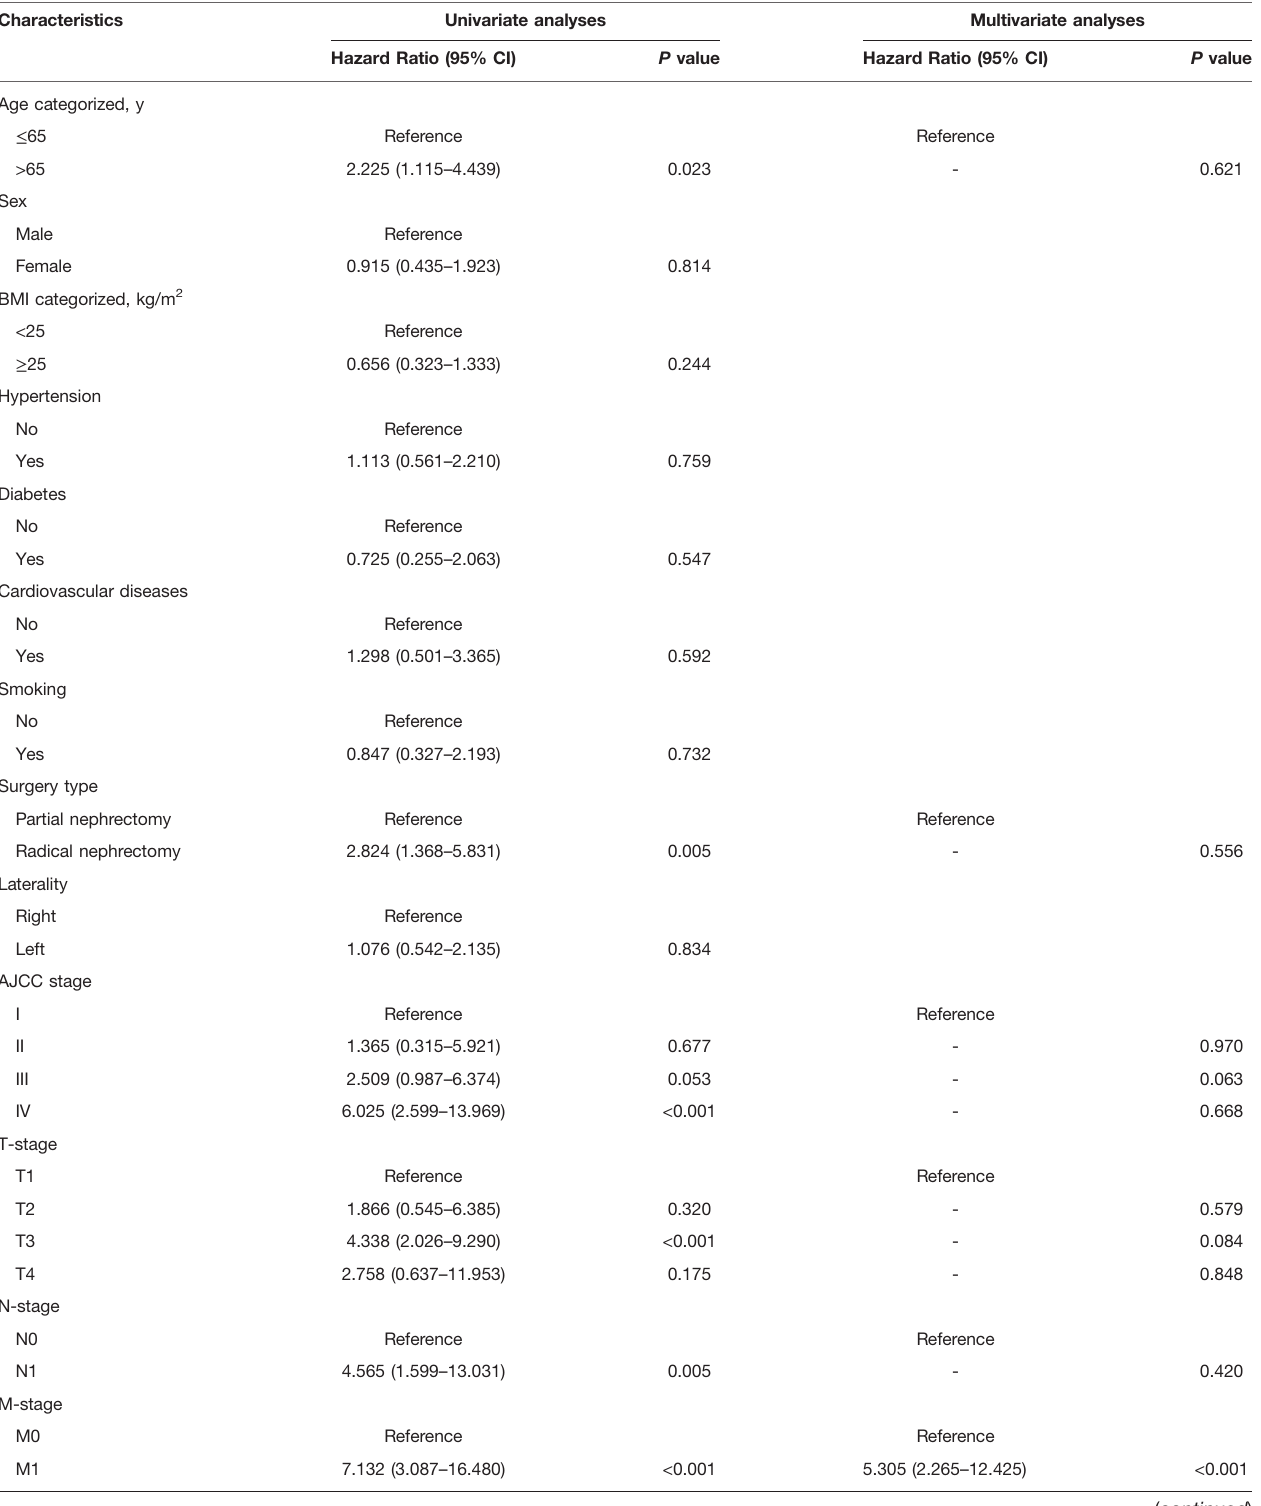
TABLE 4 | Univariate and multivariate analyses of factors associated with overall survival